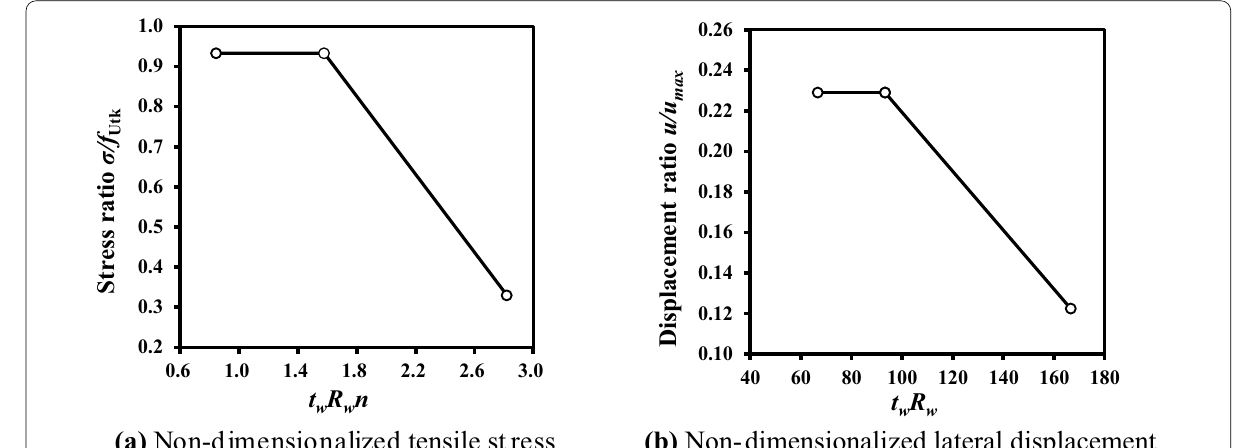
Fig. 13 Regression curves of the tensile stress and lateral displacement according to the wall thickness and wall thickness